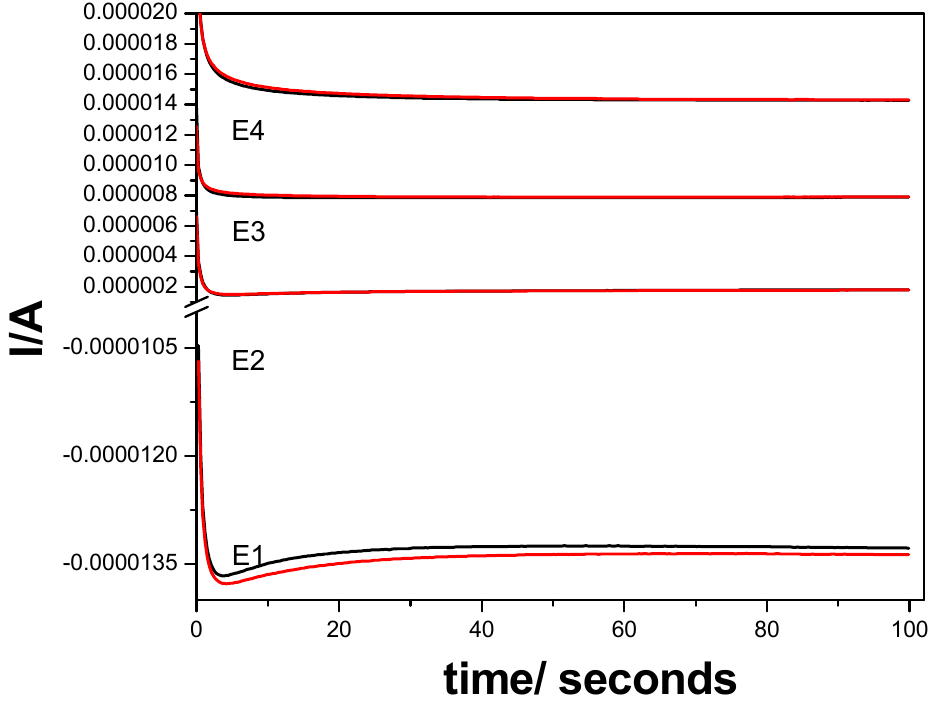
Figure 9. Multiple-pulsed amperograms recorded in tap water by applying a preconcentration step of 25 min GR-CNT electrode in 0.100 M Na 2 SO 4 supporting electrolyte and adding 0.500 µg·L − 1 DCF, recorded at E1 = − 0.400 V vs. Ag/AgCl, E2 = − 0.020 V vs. Ag/AgCl, E3 = +0.500 V vs. Ag/AgCl, and E4 = +1.500 V vs. Ag/AgCl.